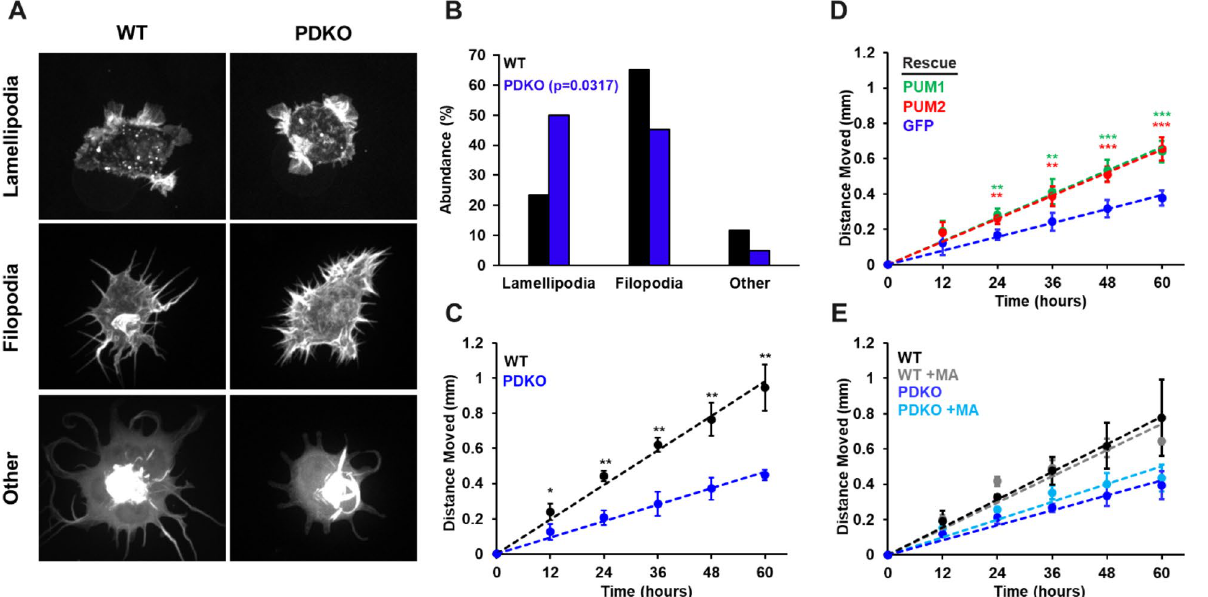
Figure 3. PUM1 and PUM2 regulate actin morphology and alter migration rate. ( A ) Representative images of WT and PDKO T-REx-293 cells transfected with mRFP-UtrCH to label filamentous actin. ( B ) Percent abundance of cells categorized to primarily contain lamellipodia, filopodia, or other structures. Cell images were scored blindly. Distributions were compared using a Chi-squared test. A total of 85 cells were analyzed. 43 WT and 42 PDKO. ( C ) Clonal ring assay migration rates of WT and PDKO cells. ( D ) Migration rates of PDKO cells rescued with PUM1, PUM2, or GFP. ( E ) Clonal ring migration rates of WT and PDKO cells with and